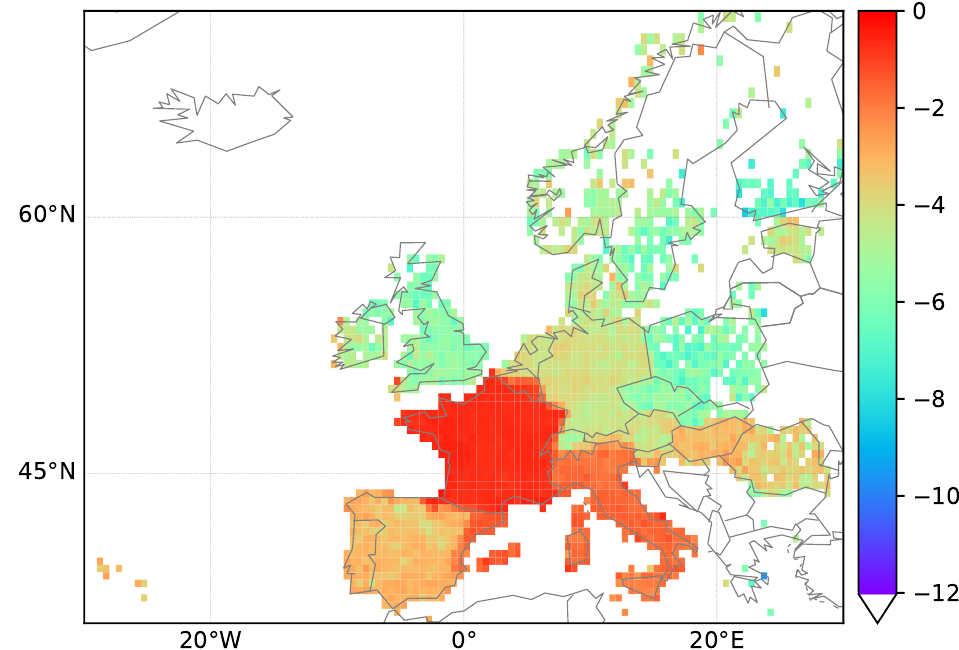
Figure 9. Heatmap of Europe showing the density of streets mapped to French street specifics. Colors indicate the density of streets in this area, thus the logarithmic value of the number of streets normalized by all streets in the cell of the grid.